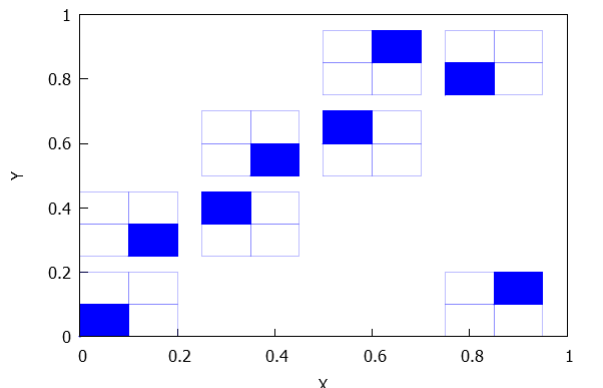
Figure 8. A and B mixing. Distribution D4. | L | = 8. Observe that p i ( π i ( R )) = 1 for any R in L and i = 1,2. Thus, | L 1 | = 4 and | L 2 | = 4. The cardinality of A and B is equal to 4, thus (cid:96) = 4; f 1 ( A ) ∩ Int ( B ) = ∅ and f 1 ( A ) ∩ B (cid:54) = ∅ , for this reason projections of rectangles have common vertices. Observe that rectangles do not have common